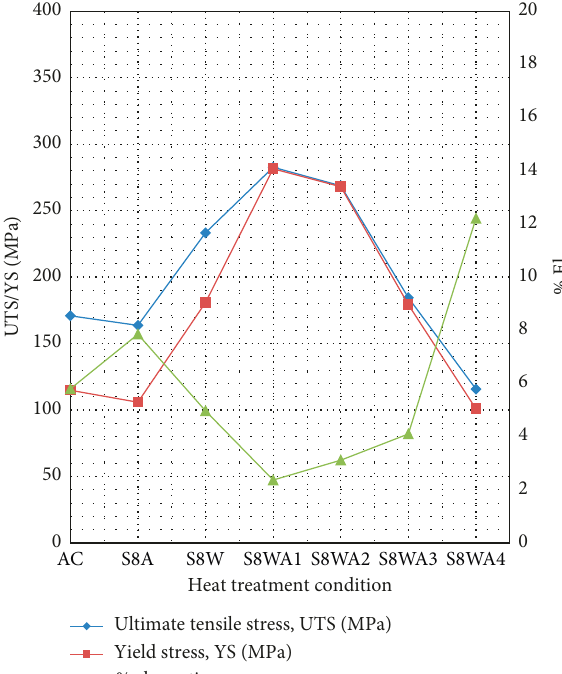
Figure 8: Average values of UTS, YS, and %El obtained at 250 ° C, for alloy C in the as-cast condition, and after heat treatments comprising SHT for 8h.